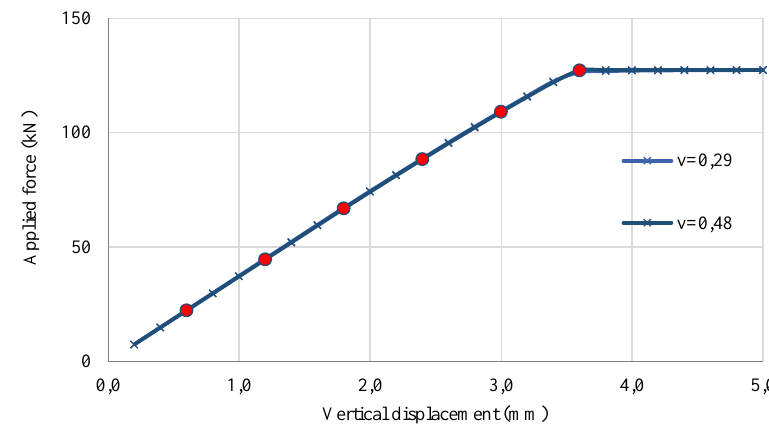
Fig. 18 Numerical results of applied force vs . vertical displacement at the outer surface of the adhesive